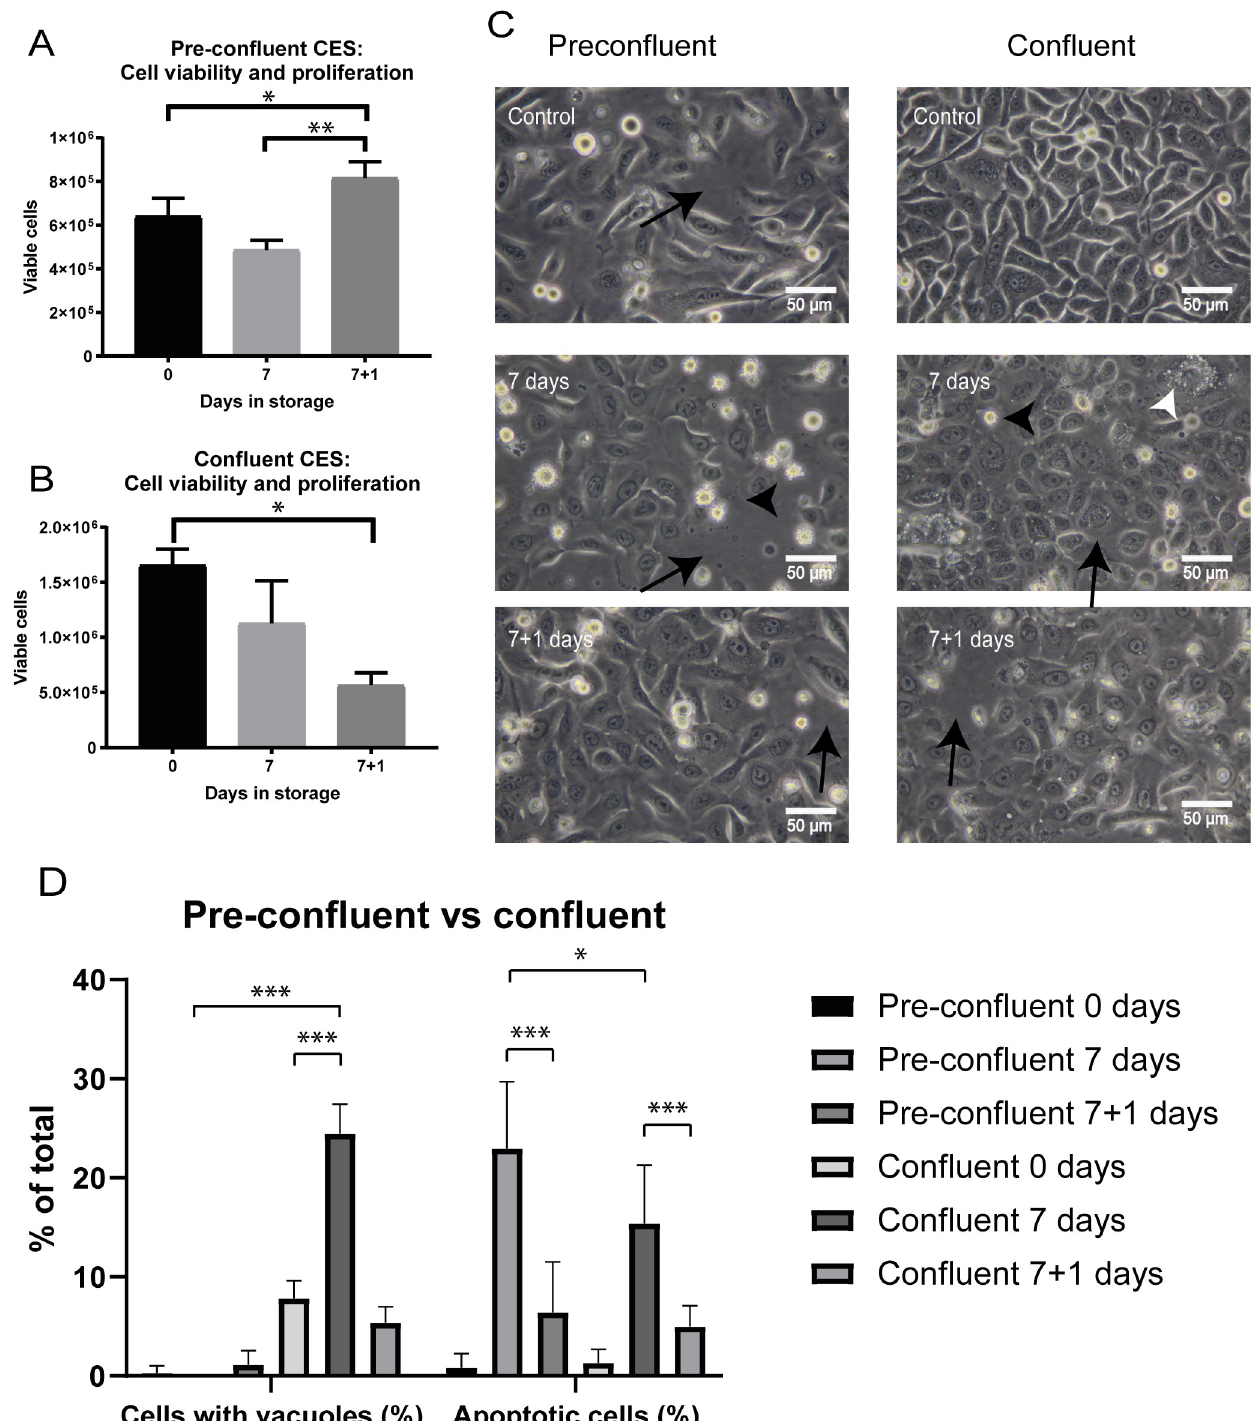
Fig 6. Comparison of the effect of confluence state and 1 day re-incubation on cell viability and cell proliferation (A) Cell count of trypan blue negative cells in CES stored at pre-confluence ( � = significant increase; p = 0.049; �� = significant increase; p = 0.0028; n = 3). (B) Cell count in confluent stored CES ( �� = significant decrease; p = 0.004; n = 3). (C) Morphology of CES, 400X magnification. Black arrows: gap in cell layer. Black arrowhead: detaching/apoptotic cell. White arrowhead: vacuoles. (D) The figure shows the percentage of apoptotic cells and stressed cells containing vacuoles. Cells were characterized and quantified using photographs (n = 6). ��� = Significant difference (p < 0.0001) � = Significant difference (p < 0.05).